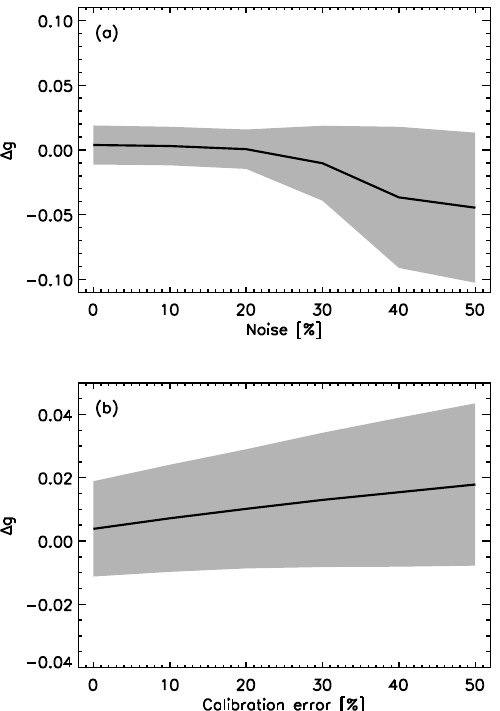
Fig. 10. Dependence of mean bias and standard deviation of re- trieved asymmetry parameters from simulated data assuming vari- ous complex habits on noise level (a) and calibration error (b) . See text for